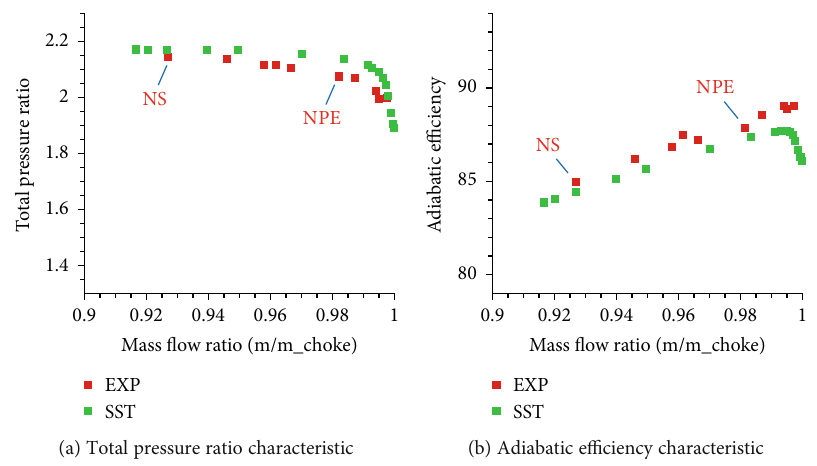
Figure 10: Comparisons of computed and measured overall performance for Rotor